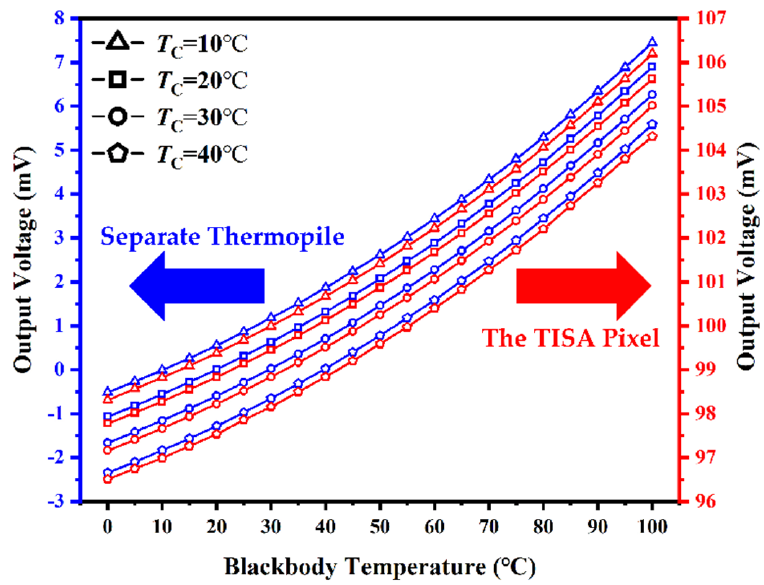
Figure 7. Output voltage curves of a separate thermopile and a TISA pixel at different chamber temperatures ( T C ) with increasing blackbody temperature.